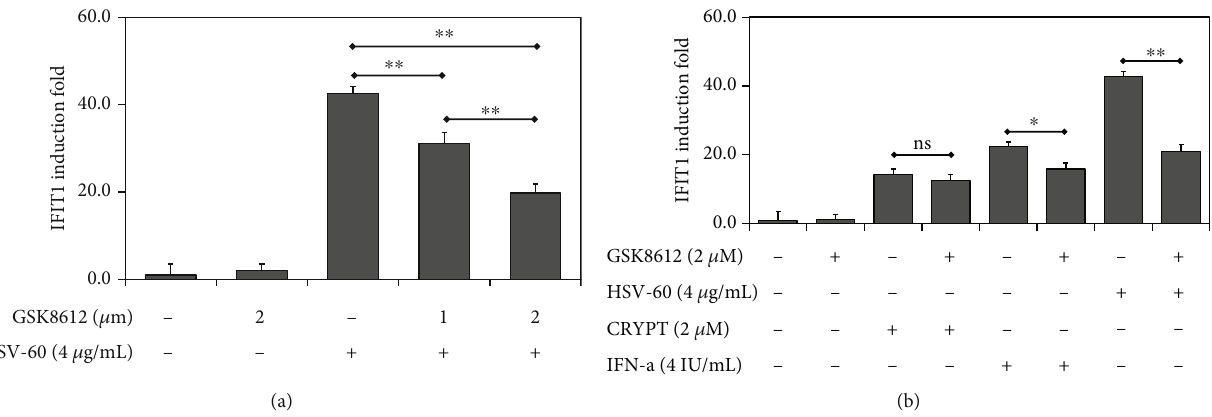
Figure 5: Cryptolepine activates IFN-1 response regardless of TBK1 inhibition in THP1-derived macrophages. The derived macrophages from the parent THP1 cells were cocultured with GSK6812 and HSV-60 (a) or GSK6812 and cryptolepine (CRYPT) (b), and the IFIT1 induction was evaluated after 24 h. Data are shown as the means, from three varied experiments with each done in triplicate, and error bars represent the standard deviations. ∗ p < 0 : 05 , ∗∗ p < 0 : 01 , and ∗∗∗ p < 0 : 001 ; ns: di ff erence not signi fi cant (one-way ANOVA and Bonferroni ’ s test (a) or Student ’ s t -test